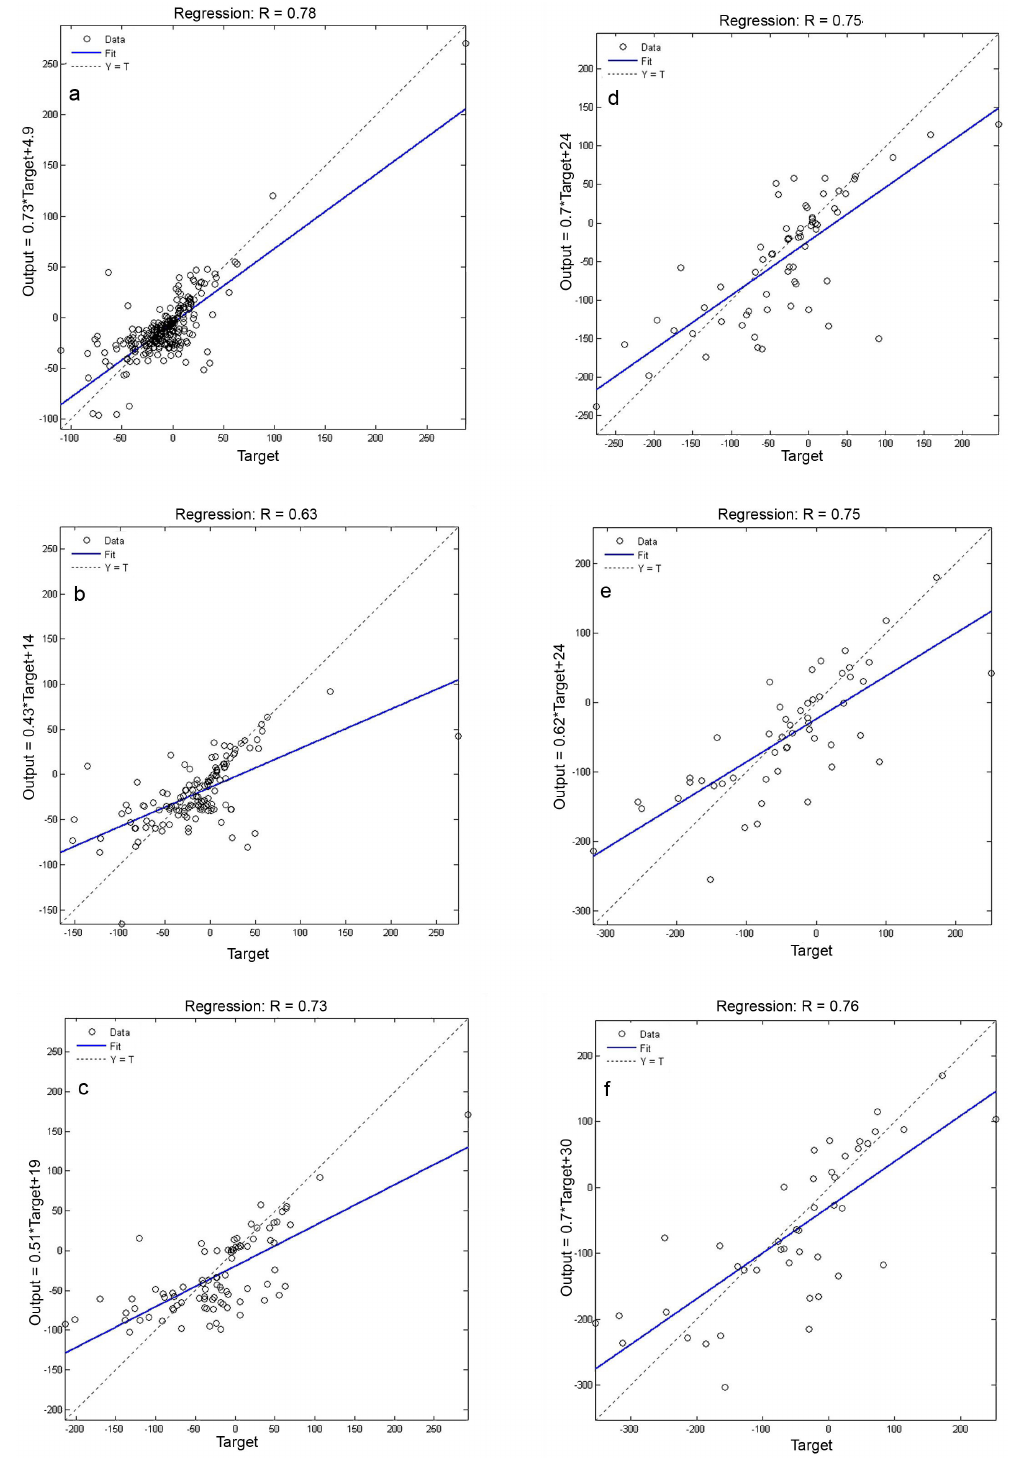
Fig. 12. Performance ANN – Test period. Correlation diagram between simulated monthly observed water storage by the ANN (output) vs. observed water storages (target) – (a) =5-day, (b) =10-day, (c) =15-day, (d) =20-day, (e) =25-day and (f) =30-day time